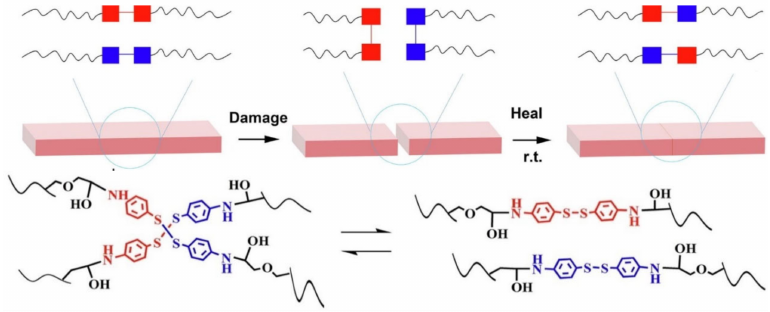
Figure 28. The self-healing siloxane elastomer. Reproduced from [173] with permission from